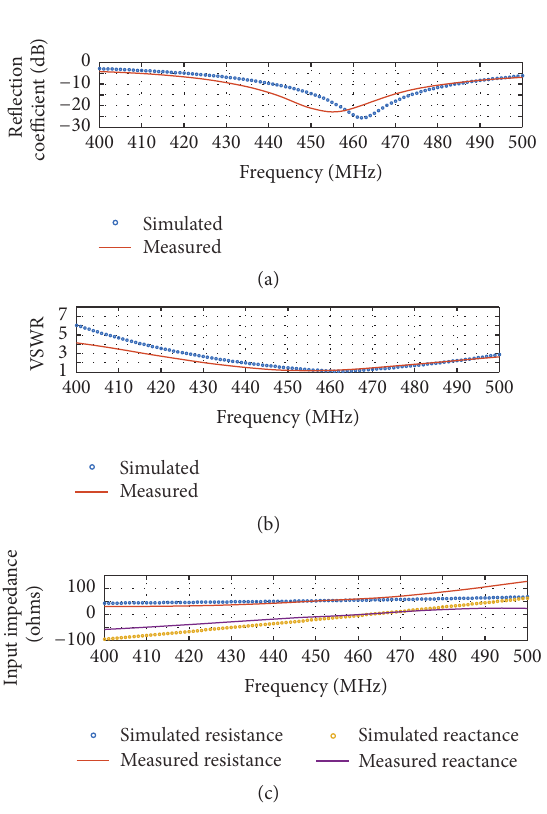
Figure 4: Frequency-dependent parameters describing the antenna behavior: (a) reflection coefficient, (b) VSWR, and (c) input impedance from 400 to 500